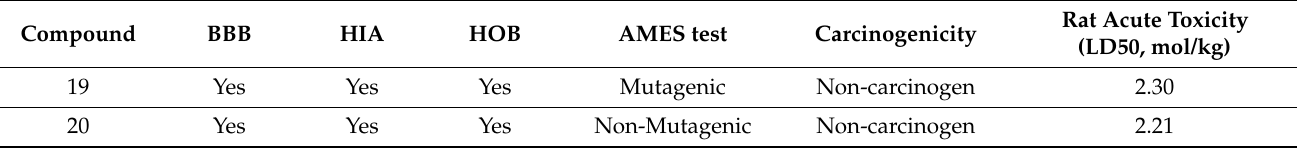
Table 3. In-silico absorption and toxicity profile of compounds 19 and 20 obtained from admetSAR server [50].